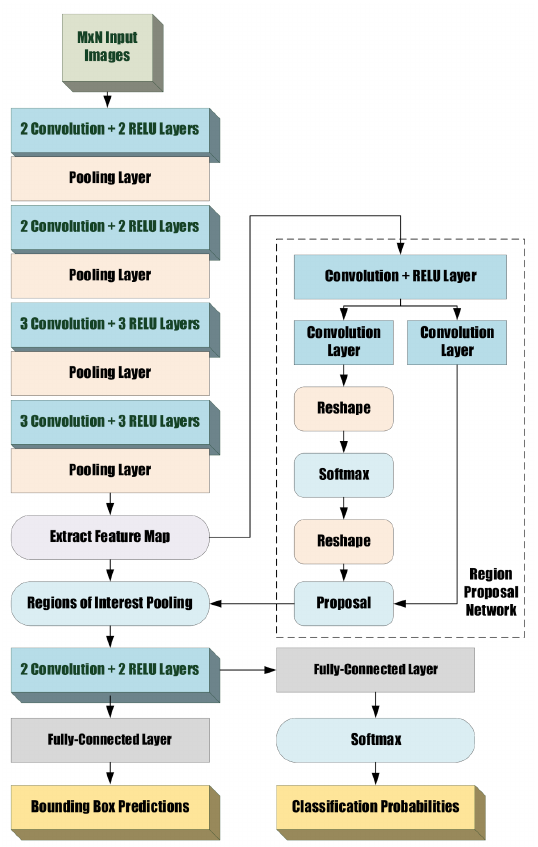
Figure 3. The structure of the Faster R-CNN